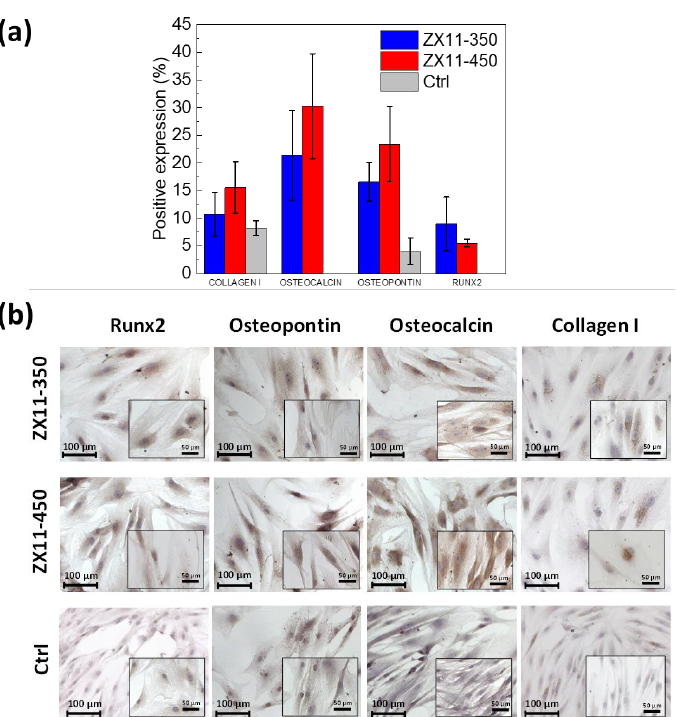
Figure 7. ( a ) Semi-quantitative evaluation, from immunocytochemistry micrographs, of Runx-2, osteocalcin, osteopontin, and collagen I cell expression ( b ) Representative immunocytochemistry micrographs of the expression of Runx-2, osteopontin, osteocalcin, and collagen I, after 8 days of MSC culture in contact with the non-diluted lixiviates from ZX11-350 and ZX11-450. Cells are observed in purple, and positive expression of markers is observed in brown. The scale bar in main micrographs corresponds to 100 µm, while scale bar in inset micrographs corresponds to 50 µm.